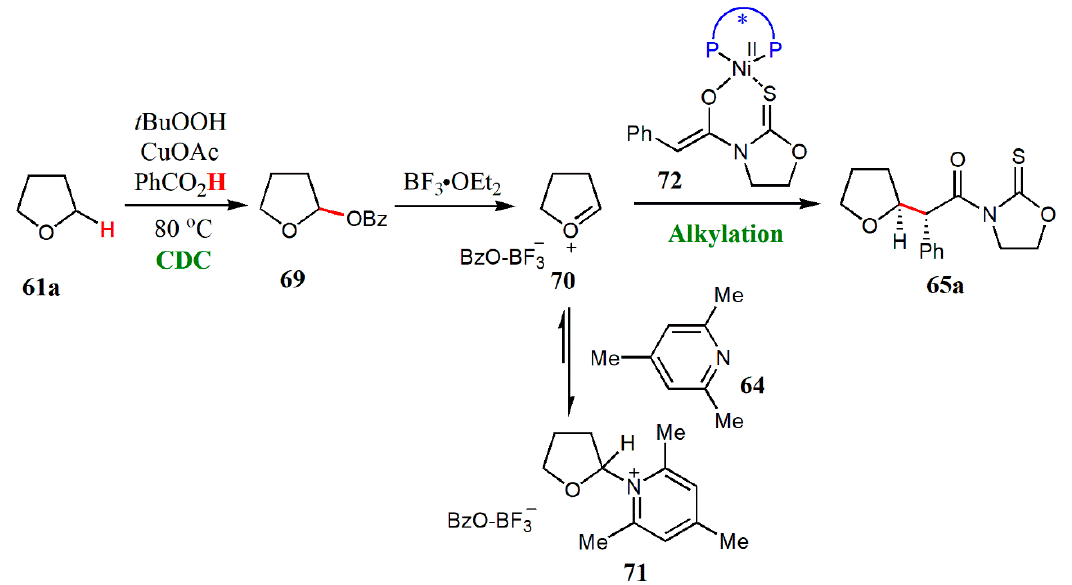
Figure 20. Proposed pathway for the CDC of the ethers 62 .